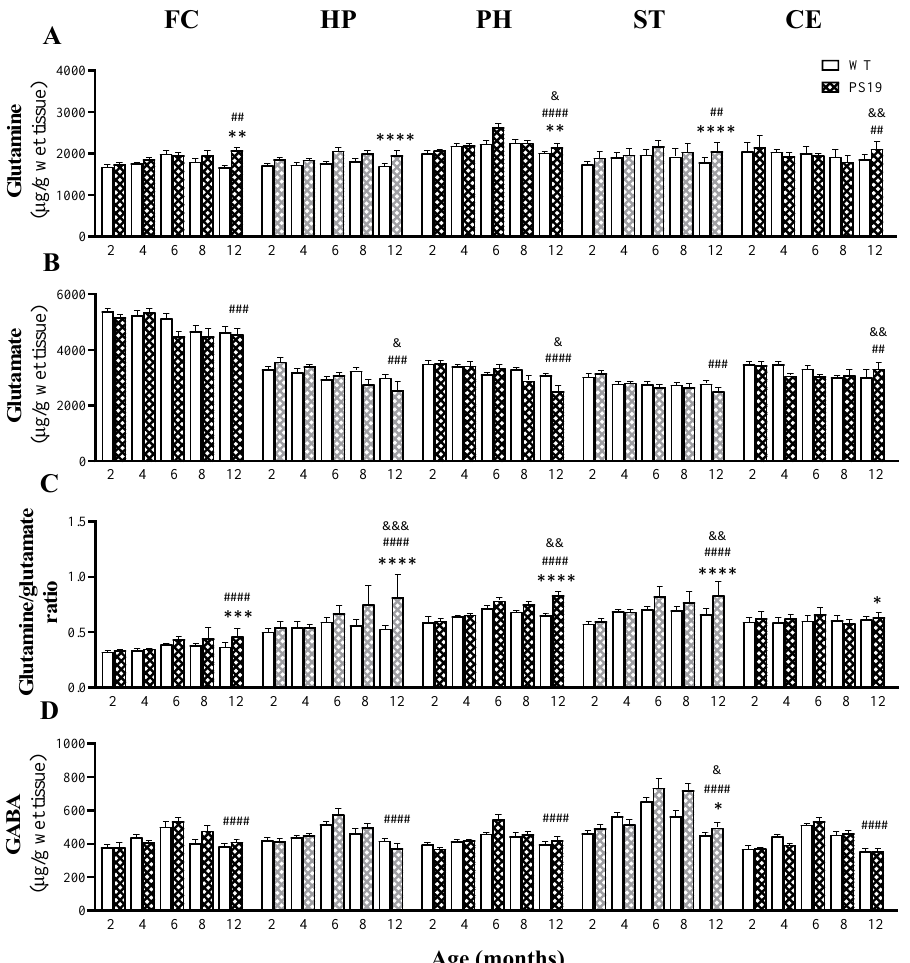
Figure 3. Mean ( ± SEM) levels of glutamine ( A ), glutamate ( B ), the glutamine/glutamate ratio ( C ) and GABA ( D ) in the frontal cortex (FC), hippocampus (HP), parahippocampal region (PH), striatum (ST) and cerebellum (CE) of wildtype (WT) and PS19 mice at 2, 4, 6, 8 and 12 months of age ( n = 7–9/genotype/age). & indicates a significant genotype and age interaction at & p < 0.05, && p < 0.01 or &&& p < 0.001. # indicates a significant age effect at ## p < 0.01, ### p < 0.001 or #### p < 0.0001. * indicates a significant genotype effect at * p < 0.05, ** p < 0.01, *** p < 0.001 or **** p < 0.0001.